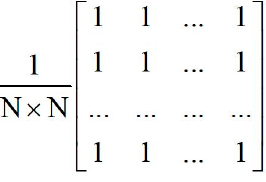
Figure 7. Average convolution operator of size N × N.